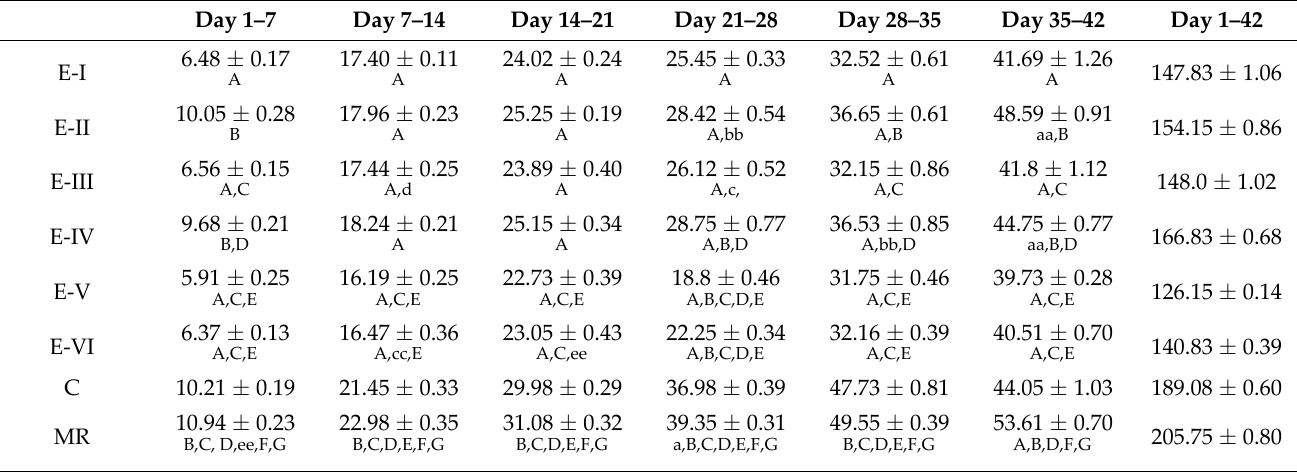
Table 3. Average body weight gain (g) of broilers during the study (x ± Sx).